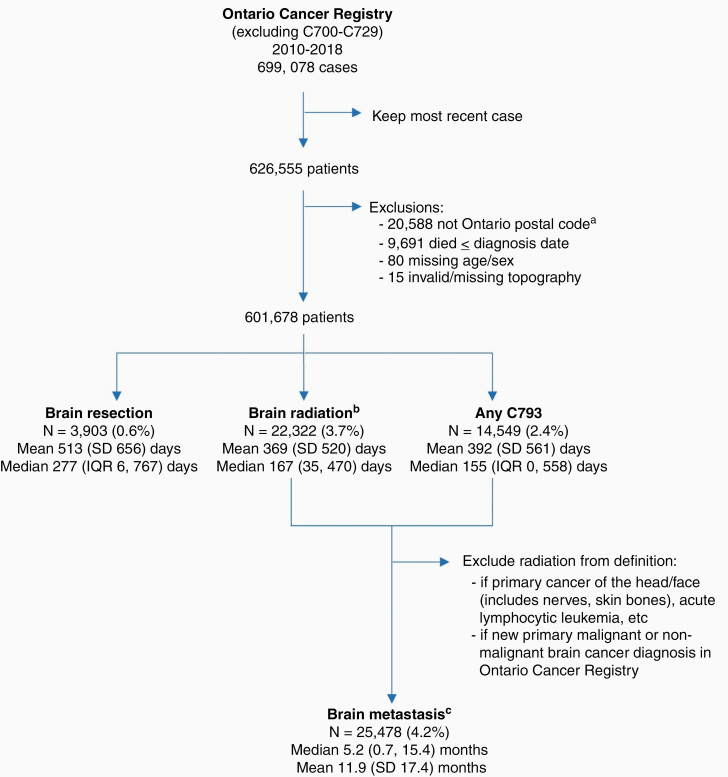
Cohort creation. Cohort creation from the Ontario Cancer Registry (OCR), excluding primary cancers of the brain and CNS (ICD Oncology version 3 codes C70-C72). Means and medians are the time from primary cancer diagnosis until brain metastasis was identified. aPostal code was derived from the OCR, which corresponds to the patients’ postal code at the time of diagnosis. b709 identified from CIHI databases only; 4,379 identified from the Activity Level Reporting database only. ICD-10—International Classification of Diseases, 10th revision; C793—ICD-10 diagnostic code “Secondary malignant neoplasm of brain and cerebral meninges”; IQR—25th, 75th percentile.